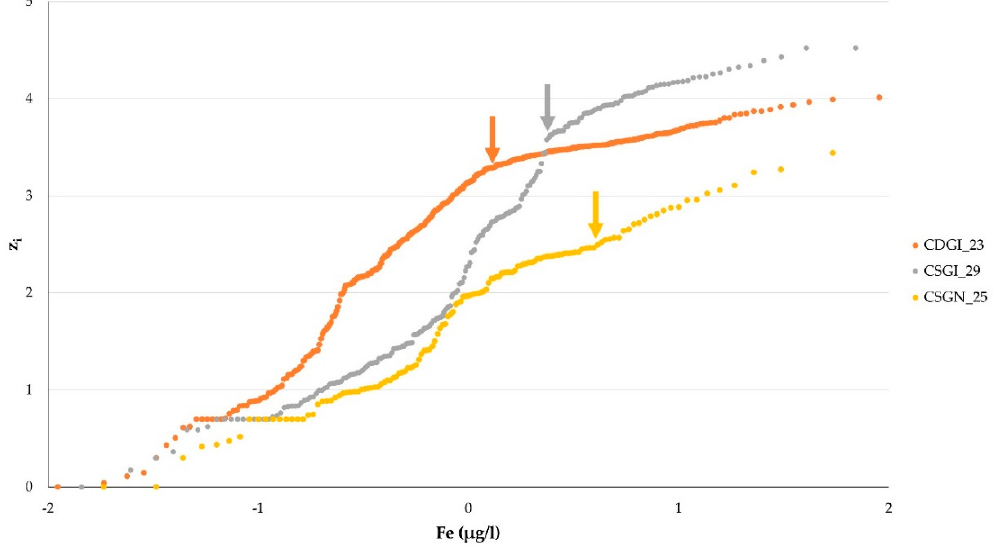
Figure 8. Lognormal probability plot of iron (Fe) for analysed groundwater bodies. Arrow indicates inflection point that separate ambient and non-ambient populations for each groundwater body.